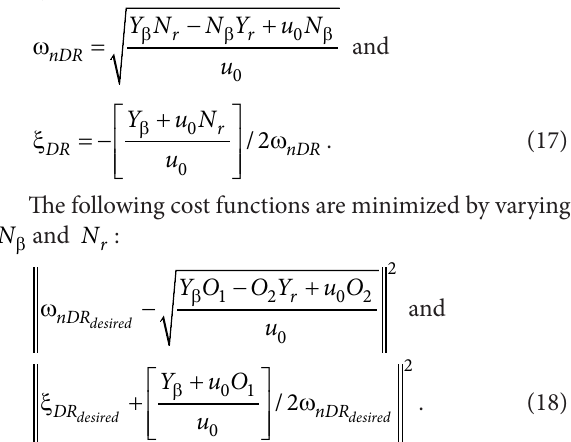
Figure 4. Cost function convergence for optimizing a desired